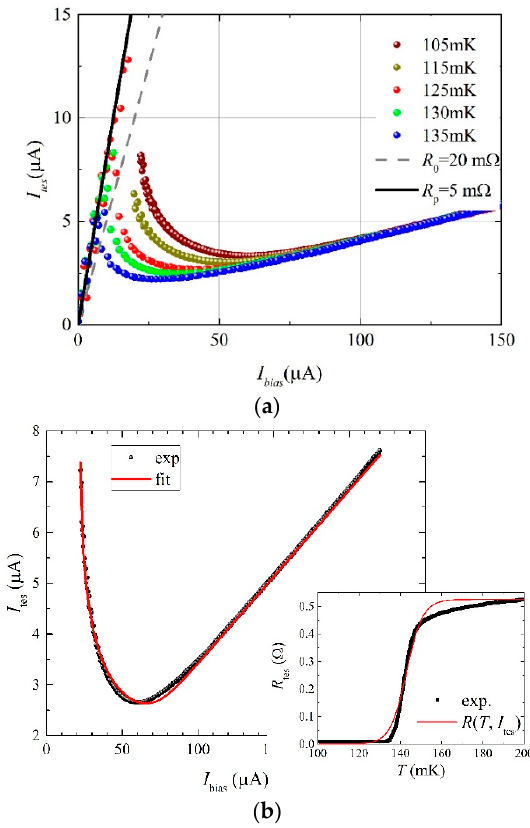
Figure 3. TES bias curve at different bath temperatures. ( a ) Dots are experimental data of I tes vs. I bias ; lines are the values at the working point R 0 and parasitic resistance R p . ( b ) I tes vs. I bias experimental data and fit at 108 mK; the inset shows a comparison between the R ( T , I tes ) curve calculated by Equation (2) and the corresponding one of Figure 1.